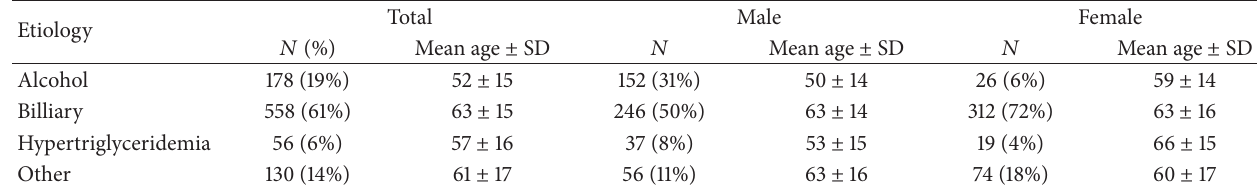
Figure 3: (a) The commonest causes of AP in men (HyperTG: hypertriglyceridemia). (b) The commonest causes of AP in female patients. One should note the rather low proportion of alcoholic AP as opposed to men (HyperTG: hypertriglyceridemia). (c) The commonest causes of AP in all patients (HyperTG: hypertriglyceridemia). Table 1: The average age of patients with regards to the etiology of acute